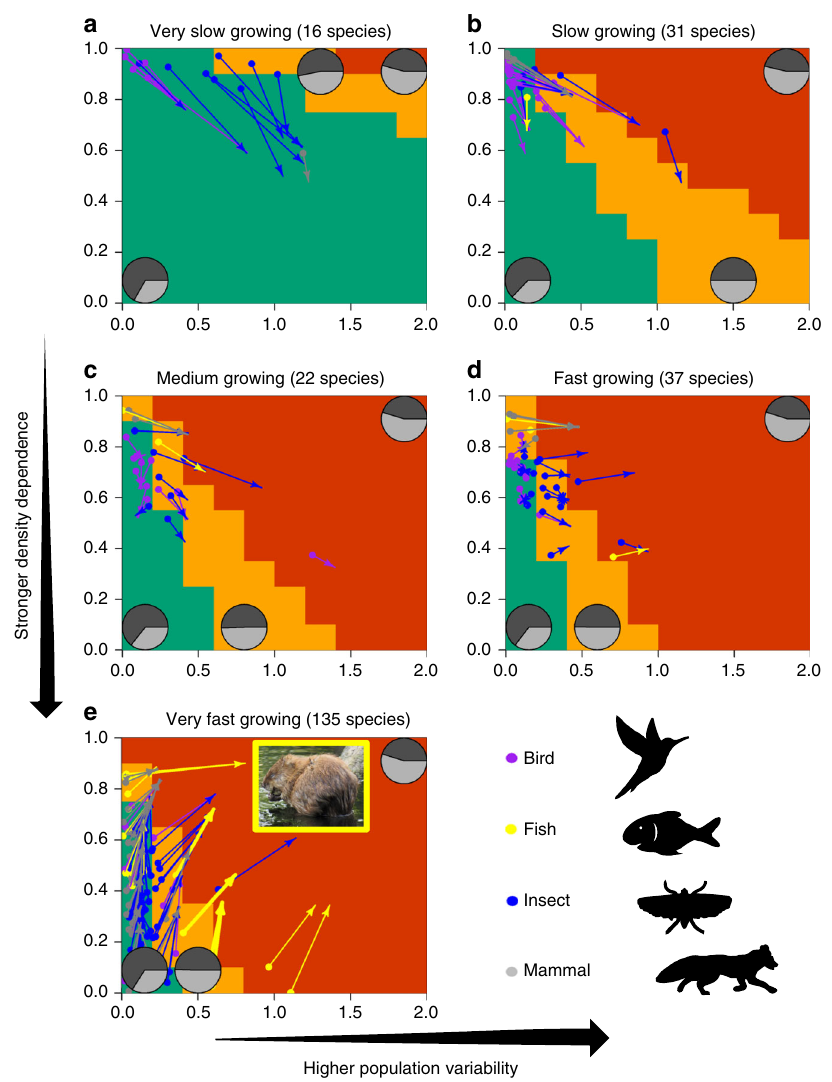
Fig. 2 Risk of biased population status estimate. Risk maps of biased population status estimate across four taxonomic groups (birds, fi sh, insects, and mammals) with a time series length ranging from 21 to 30 years. Risks are quanti fi ed as having more than 60% (orange-red), 30 – 60% (orange), and below 30% (bluish-green) chance of estimating the fi nal-year depletion level (how much the population has changed compared to the start of the time series or another reference point) with at least 50% bias in both directions. Risk are quanti fi ed based on the results from extensive (135,000 scenarios) simulation – estimation study. The risk map is summarized in 2D based on total (both process and observation) population variability measured in terms of coef fi cient of variation and population density dependence. The plot is restricted to the parameter range used in the simulation studies. The panels are organized by the species intrinsic rate of growth from very slow-growing (0 – 0.3) ( a ), slow-growing (0.3 – 0.7) ( b ), medium-growing (0.7 – 1.1) ( c ), fast- growing (1.1 – 1.5) ( d ), to very fast-growing (>1.5)) ( e ) species. The fi lled dots are the estimated parameter values for the four taxonomic groups (birds (purple), fi sh (gray), insects (blue), and mammals (yellow)) and the arrows show the most plausible ( “ true ” ) parameter values that could have generated such estimates. The pie chart within each panel identi fi es the sign of estimation bias for each risk category i.e., false-positive (thinking the population is more than 50% healthier than it really is) in dark gray and false-negative (thinking the population is more than 50% in poorer condition that it actually is) in light gray. The thicker yellow arrows illustrate the example of muskrat (photo credit: Wikimedia Commons) from different regions of